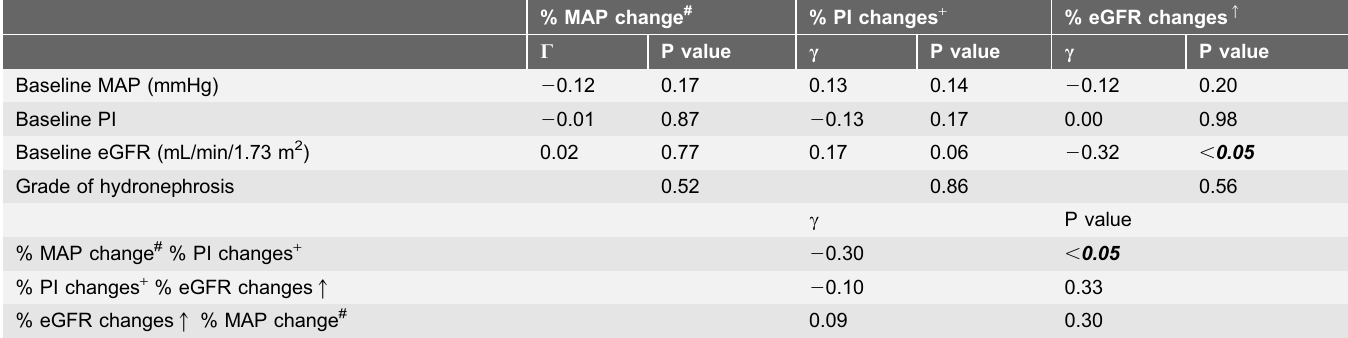
Table 3. Relationships between baseline clinical parameters and the percent changes in MAP, PI, eGFR after stone disintegration.